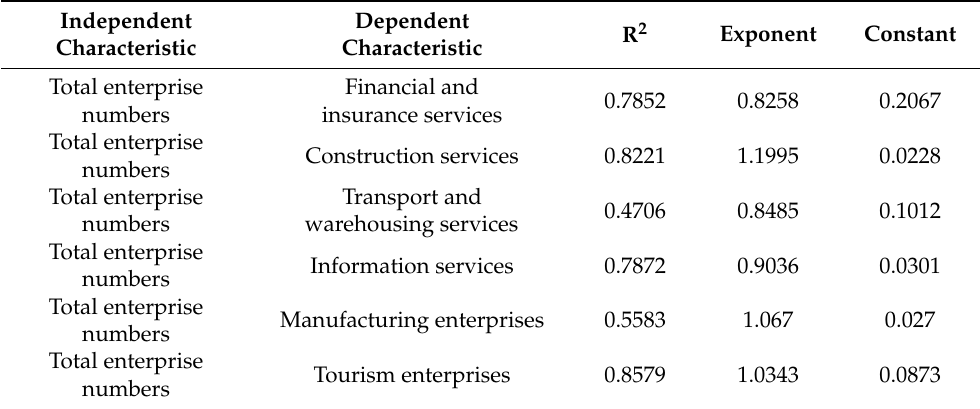
Figure 4. The power-law association between total enterprise numbers and the combined numbers of wholesale and retail enterprises in US micropolitans. The power law has a sub-linear exponent of 0.94. Table 3. The power-law associations between total enterprise numbers and the enterprises of different business sectors of US micropolitans. R 2 represents the fraction of variation